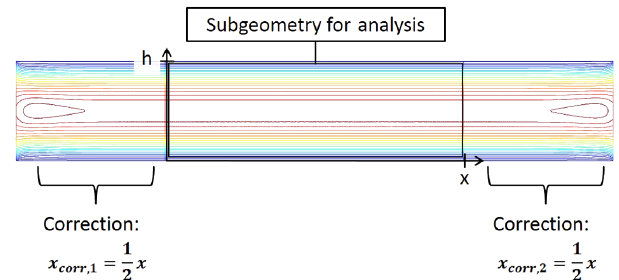
Figure 2. Model set-up for the model validation using plane Poiseuille flow. Coloured lines indicate isolines of velocity, whereas blue and red colours define lower and higher velocities respectively. The subgeometry used for the analysis is marked by the black box.